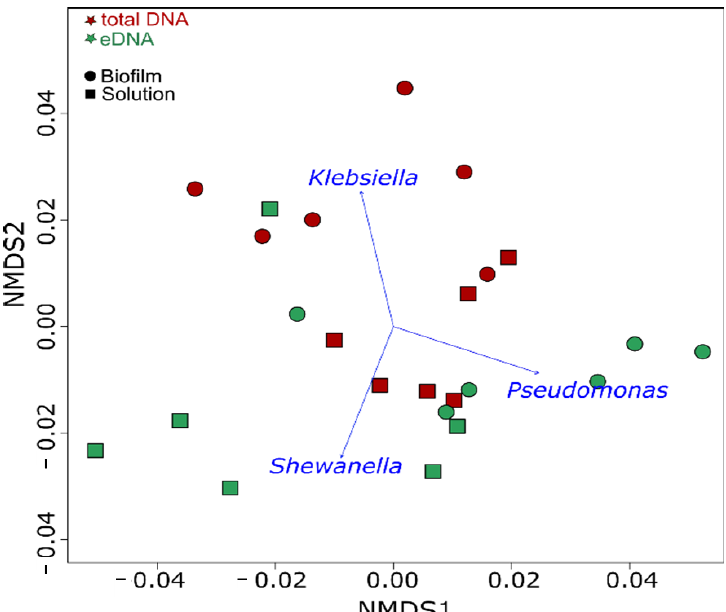
Figure 8. NMDS of the microbial communities at each sampling period. Microbial taxa significantly correlated ( p = 0.001) with microbial community structure are indicated by blue arrows.